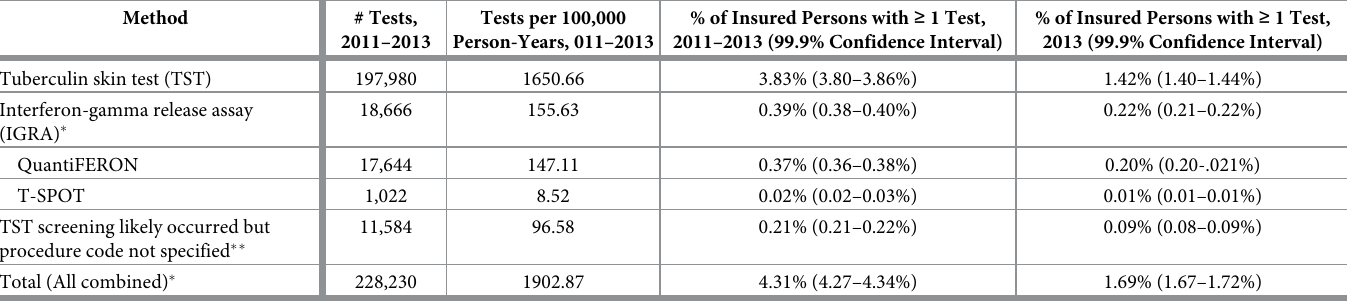
Table 1. Rates of screening for Mycobacteriumtuberculosis with tuberculin skin tests (TSTs) or interferon-gamma release assays (IGRAs) in commercially insured individuals ages 0 to 64 years, based on data from the Optum Clinformatics Data Mart Database (N = 3,997,986).